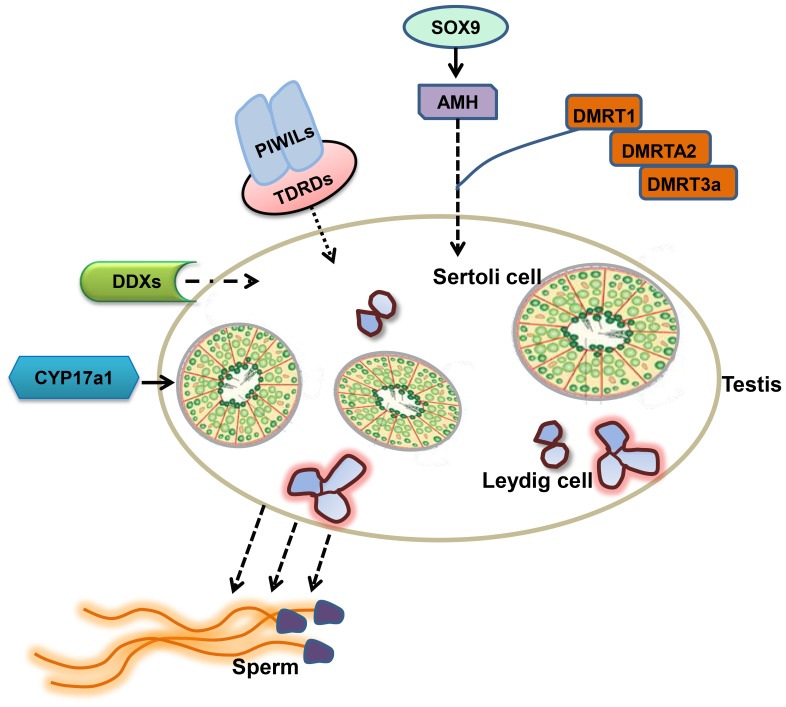
Putative catfish spermatogenic pathway based on RNA-Seq expression signatures in channel catfish testis.